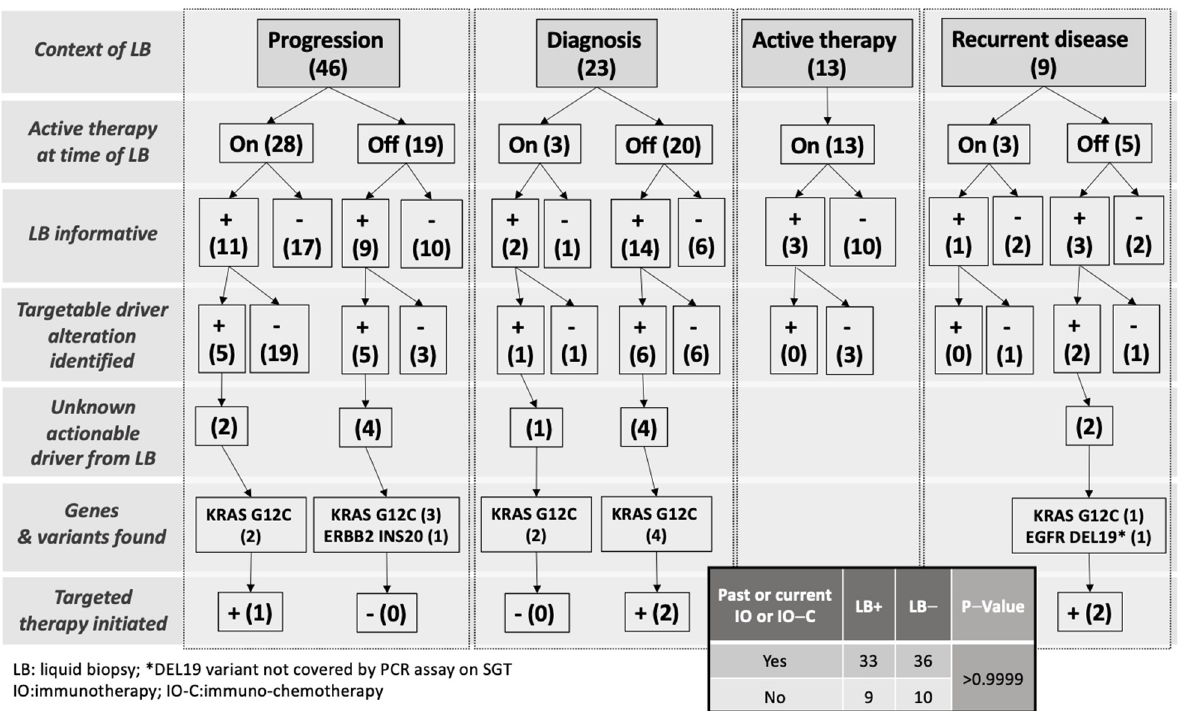
Figure 2. Detailed breakdown of liquid biopsy results with outcome on targeted therapy during the study. Numbers in brackets represent number of cases ( N ). Table 4. Cases with potentially targetable driver alterations identified by tissue testing Table 2. Liquid biopsy SNV/indel detection rate per clinicopathological categories.